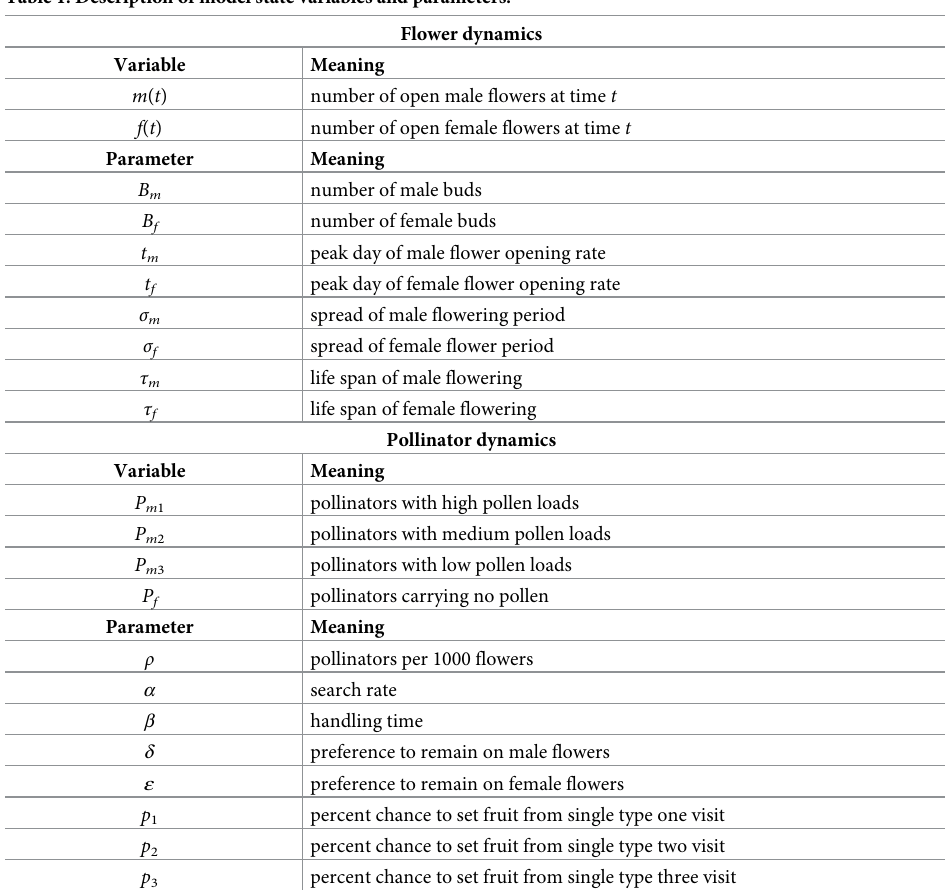
Table 1. Description of model state variables and